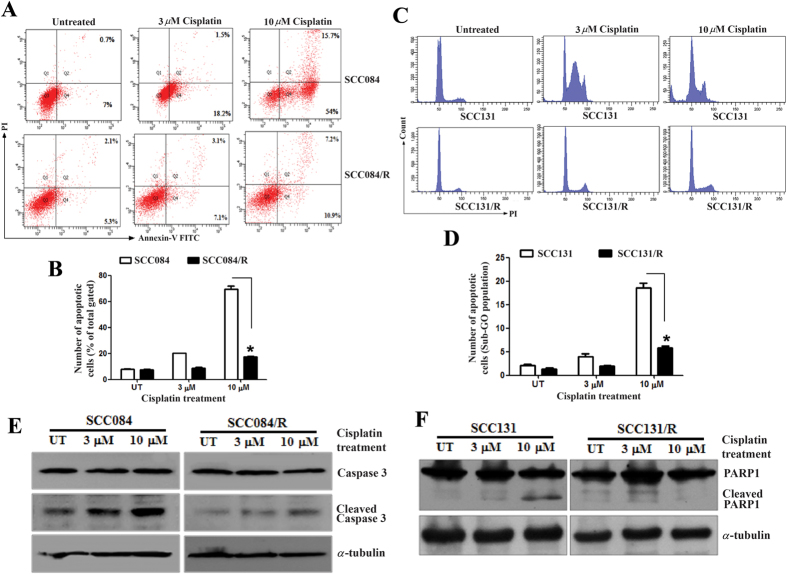
Cisplatin induces apoptosis in parental cells significantly compare to resistant OSCC cells.(A) Quantification of apoptosis by annexin V binding to SCC084 and SCC084/R cells. Cells were incubated with indicated doses of cisplatin for 48 h and then stained with annexin V-FITC/PI and analyzed by flow cytometry. (B) Bar diagram represent the mean ± SE calculated from three independent experiments. (C) Cell cycle distribution of SCC131 and SCC131/R cells following cisplatin treatment for 48 h. After staining with propidium iodide they were analyzed using a flow cytometer. (D) Each column represents the percentages of cells in sub-dipliodal (Sub-G0/G1) population of cell cycle at indicated time after treatment. Data represent the mean ± SE calculated from three independent experiments. (E) Representative image of caspase 3 cleavage by western blot using cleaved Caspase 3 antibody in SCC084 and SCC084/R cells. Cells were incubated with indicated doses of cisplatin for 48 h and then whole cell lysates analyzed by western blot for caspase 3 and cleaved caspase 3 protein product. α-Tubulin was used as a loading control. (F) Effect of cisplatin on the cleavage pattern of PARP1 in SCC131 and SCC131/R cells. Cells were incubated with indicated doses of cisplatin for 48 h and then whole cell lysates were for western blotting for cleaved and total PARP1 using specific antibody. α-Tubulin was used for normalization. For (A,C,E) and (F), images are representative of three independent experiments. *p < 0.05, **p < 0.01, ***p < 0.001.